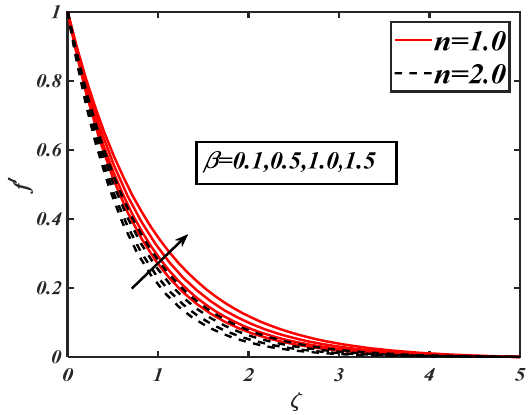
β illustration against f